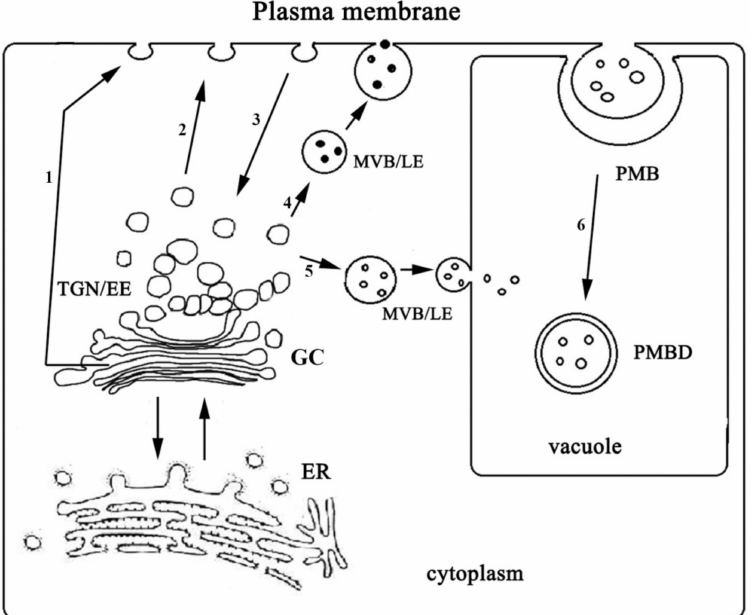
Figure 8. A hypothetical scheme outlining effects of Atflot1ko mutation on the vesicle traffick- ing pathways and P-type H + -ATPase content in the plasma membrane of A. thaliana root cells in control and salt stress conditions. Abbreviations are as follows: ER—endoplasmic reticulum, TGN/EEs—trans-Golgi network/early endosomes, MVBs/LEs—multivesicular bodies/late endo- somes, PMB—paramural body, and PMBD—derivative of paramural body. Vesicular trafficking pathways are as follows: 1, 2, 4—exocytosis; 3, 6—endocytosis, 5—vacuolar pathway. Under control conditions, the inhibition of the canonic pathways proceeding via LE/MVB formation (4, 5), stimu- lation of alternative exocytosis pathways bypassing the formation of MVBs (1, 2), and increase in P-type H + -ATPase content in PM occur. Under salt stress conditions, the inhibition of GC production resulting in elimination of both canonic (4, 5) and alternative (1, 2) exocytosis pathways, and a decrease in P-type H + -ATPase content in PM, take place. The endocytic MVB-mediated pathway accompanied by the production of PMBDs (6) undergoes alterations by the Atflot1 mutation